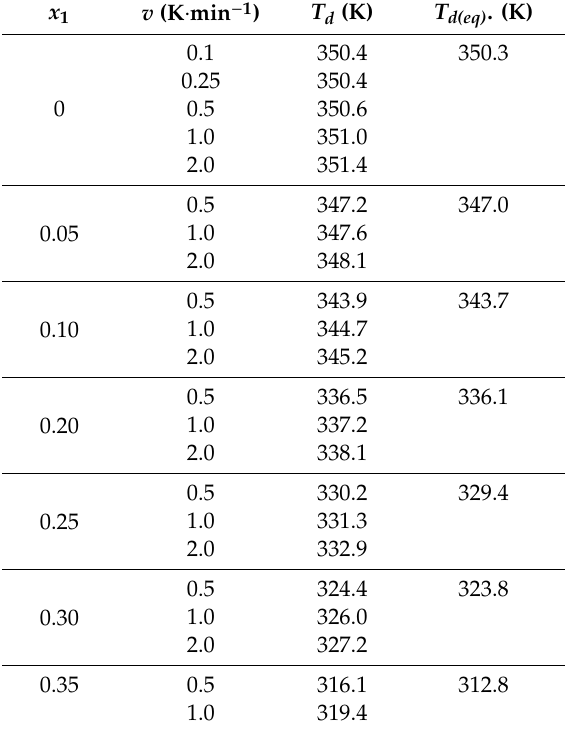
Table 2. The peak maximum temperatures T d for denaturation of lysozyme in water and in the DMSO–water mixtures ( x 1 is a mole fraction of DMSO) at di ff erent heating rates in the DSC experiments and the estimates of equilibrium denaturation temperatures T d(eq)